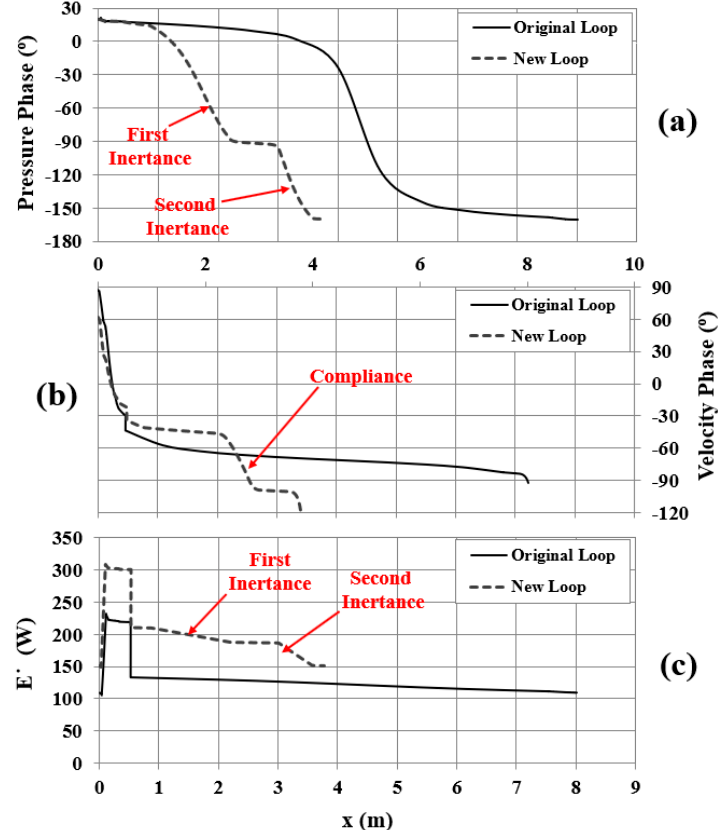
Figure 17. One-stage simulation results comparing the original and new feedback loop: ( a ) pressure phase, ( b ) velocity phase and ( c ) acoustic power flow along the engine.